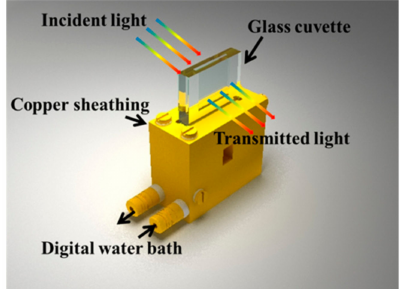
Figure 2. Schematics of the measuring device for the optical transmittance of